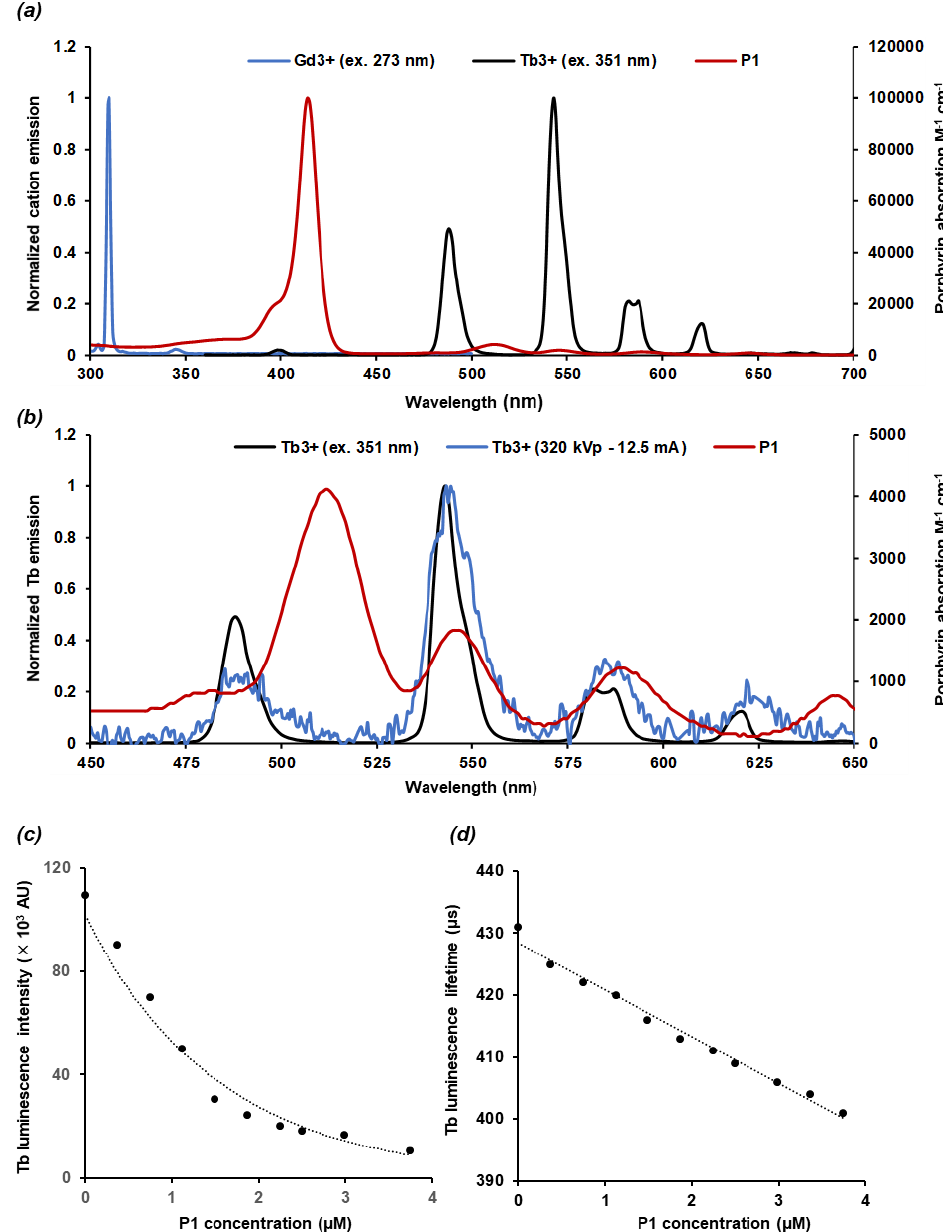
Figure 1. Photo-physical properties of AGuIX@Tb-P1 nanoparticle. ( a ) P1 absorption spectrum, AGuIX@Gd-P1 and AGuIX@Tb-P1 emission spectra (after 273 and 351 nm excitation, respectively, in water. Data presented in ( b ) is a zoomed view of the P1 Q bands, between 450 and 650 nm. Tb 3+ emission overlap after UV (351 nm) or Tb 3+ X-ray exposition; the tube parameters were set